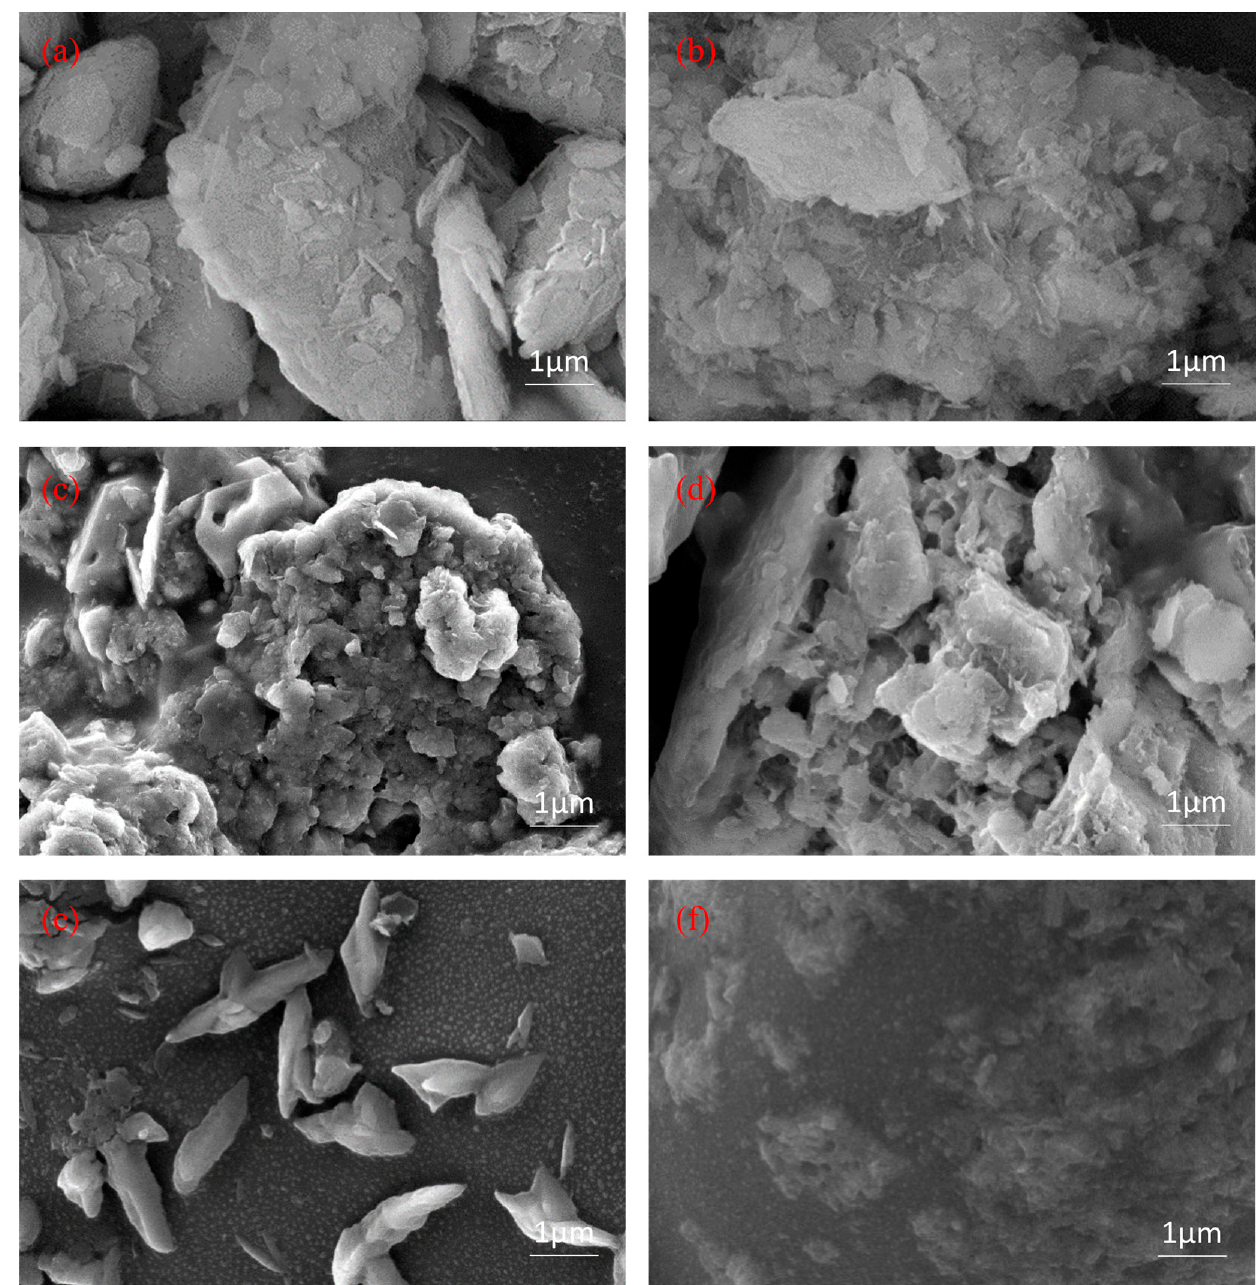
Figure 3. SEM images: ( a ) APT; ( b ) APT modified by 6 mol/L sulfuric acid; ( c ) CSF; ( d ) Starch-lignin- APT; ( e ) lignin-PAM; and ( f ) APT-PAM.